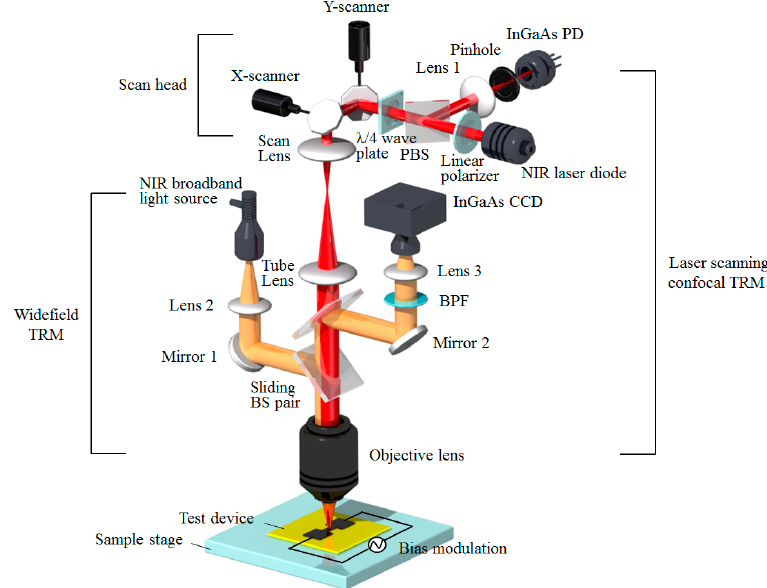
Figure 1. Schematic diagram of the NIR laser scanning confocal TRM system. The system also includes a widefield TRM system. Photodiode: PD, Polarizing beam splitter: PBS, Bandpass filter: BPF, Beam splitter: BS.